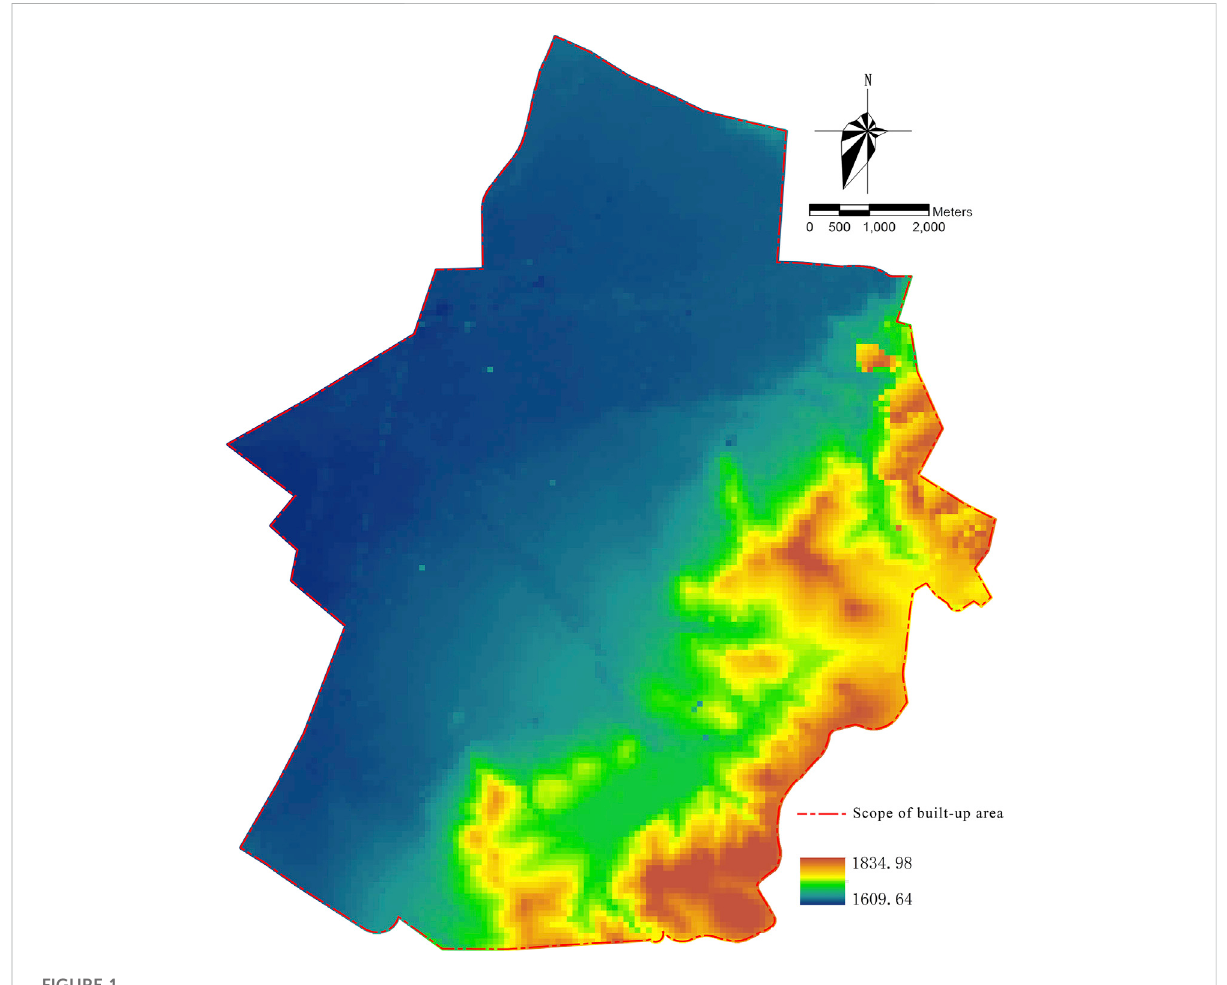
FIGURE 1 The DEM elevation of built-up area in Yuxi